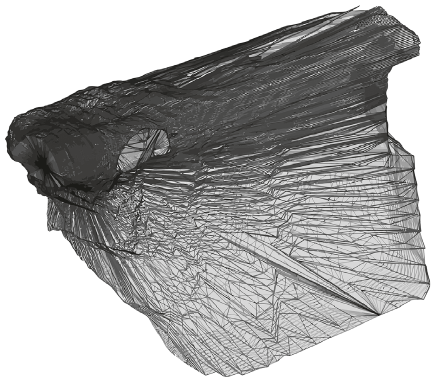
Figure 10: Cavity scanning